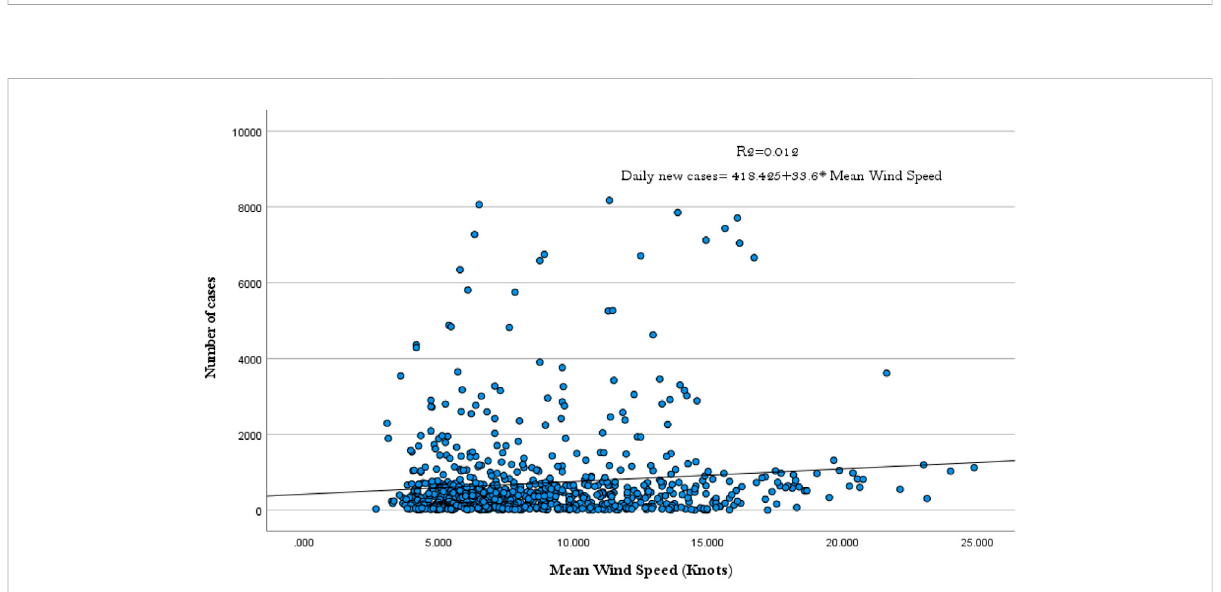
FIGURE 10 Scatter diagram and simple regression line presenting the relationship between new daily cases of SARS-CoV-2 and mean average wind speed in Bahrain for 27 months of recorded cases.